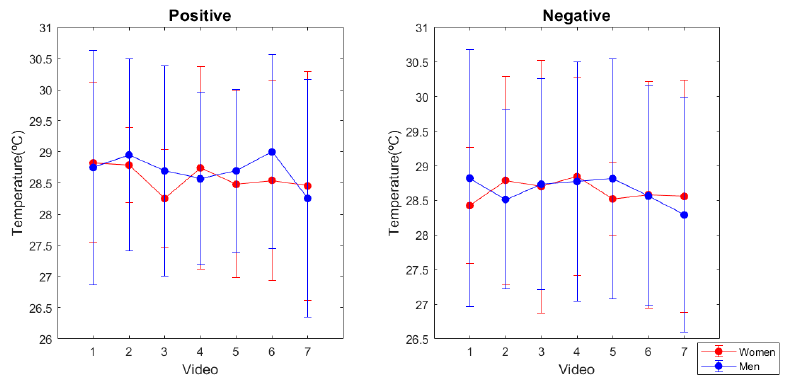
Figure 3. Mean temperature values for every positive and negative audiovisual stimulus used. Videos are ranked from lowest to highest score on the valence scale.